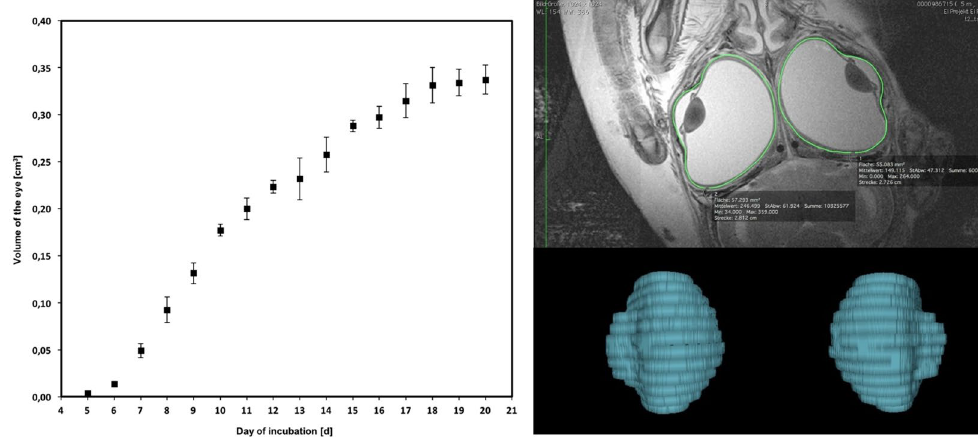
Figure 7. Volume of the eyeball from E5 to E20, as measured by MRI.